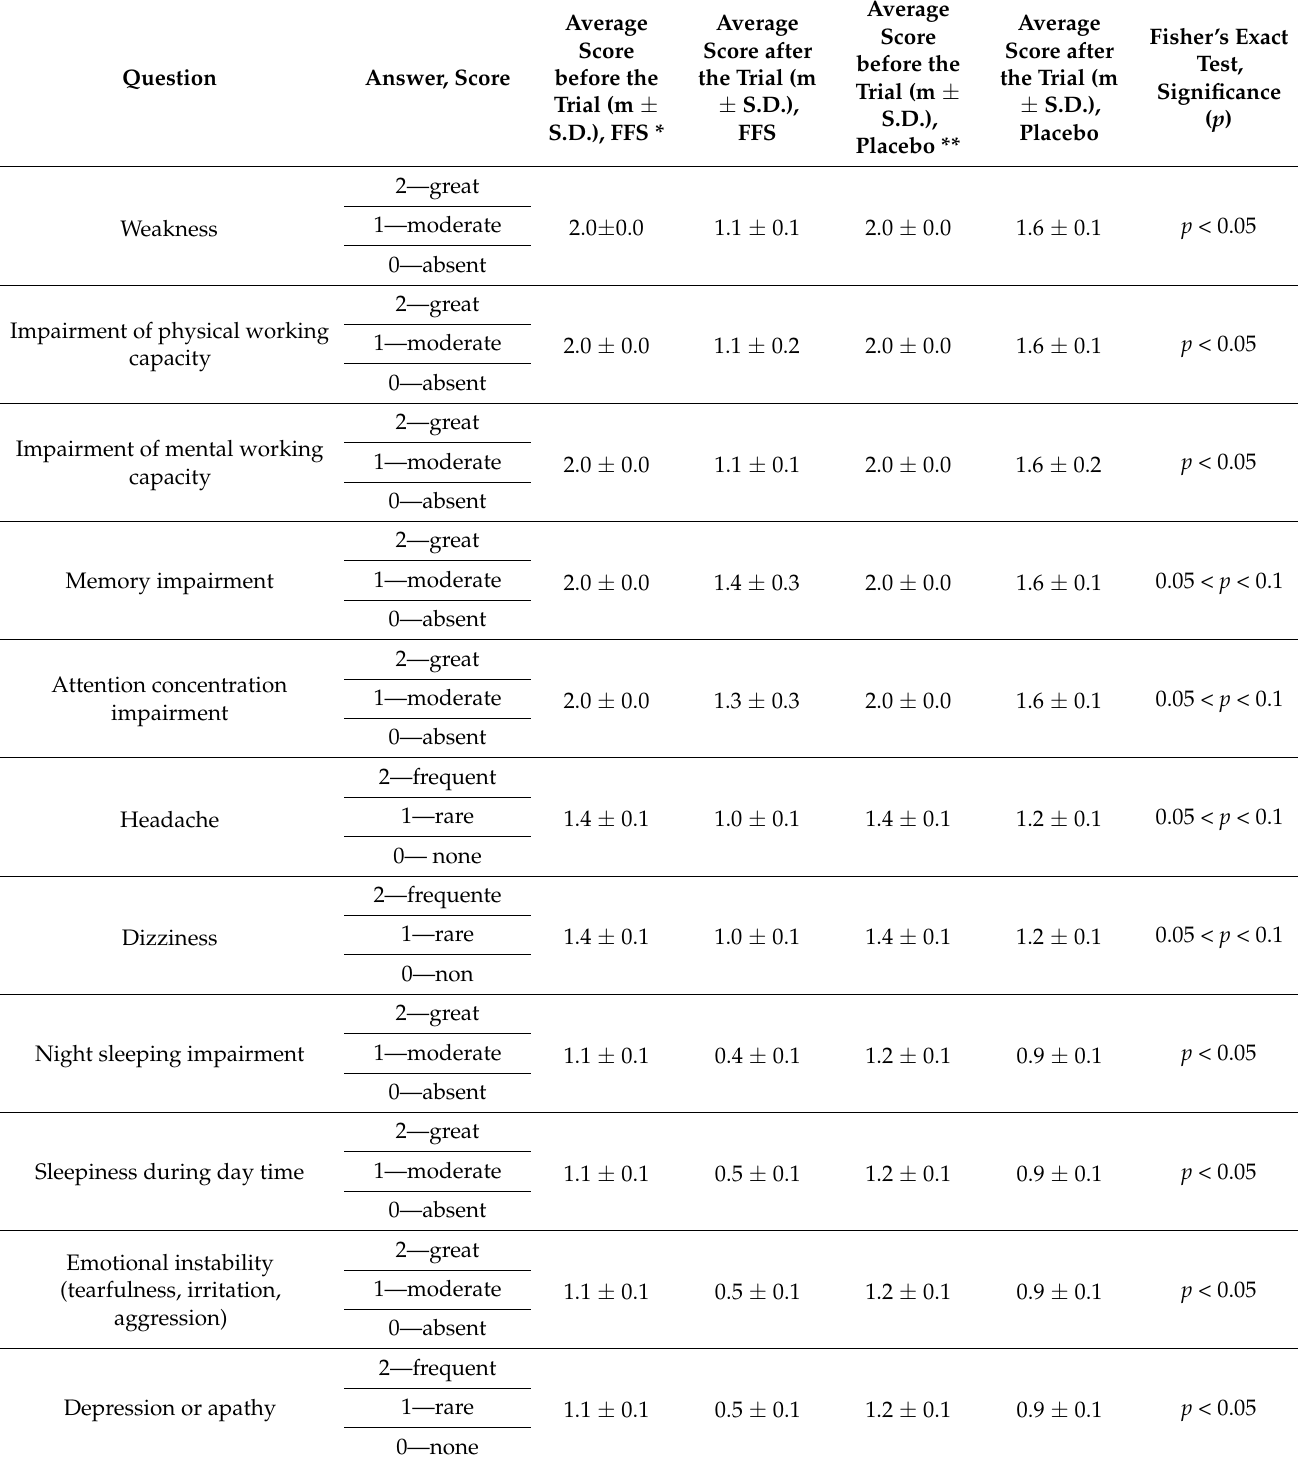
Table 2. Subjective opinions of post-COVID patients (n = 91, severe COVID